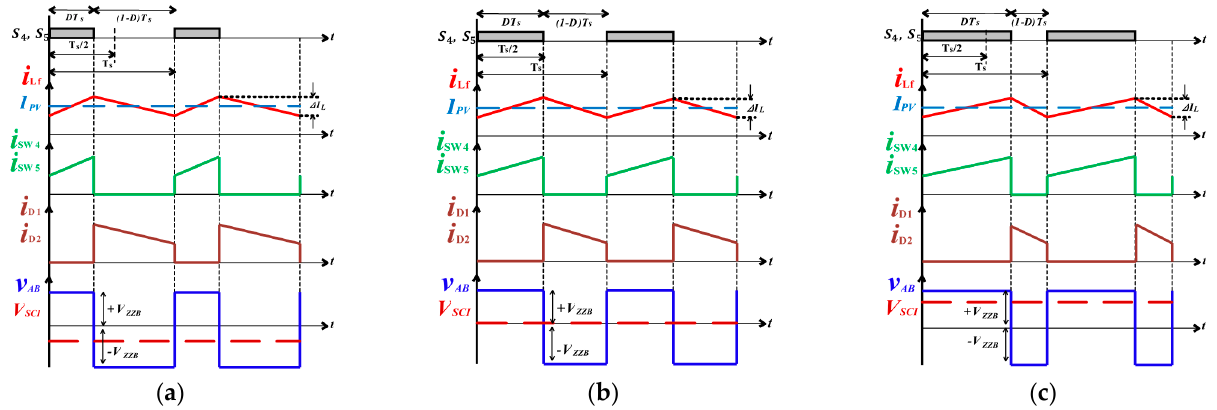
Figure 6. Bipolar PWM method for the operation of SCI and the corresponding voltage and current waveforms for different components showing that the output voltage of SCI is: ( a ) negative for (0 ≤ 𝐷 < 0.5) ; ( b ) zero for (𝐷 = 0.5) ; ( c ) positive for (0.5 < 𝐷 ≤ 1) .